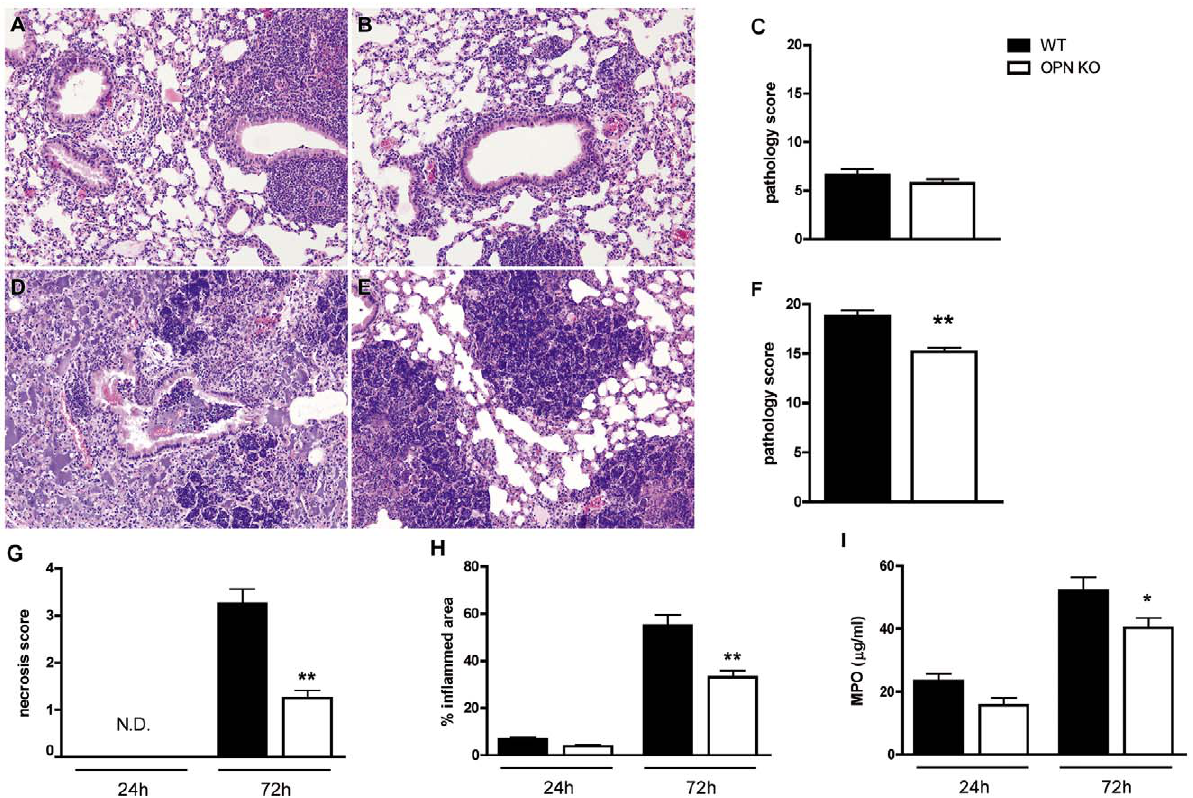
Figure 4. Reduced lung pathology in OPN KO mice. Representative lung pathology of WT (A, D) and OPN KO (B, E) mice 24 (A–C) and 72 (D–F) h after intranasal infection with 10 3 CFU of B. pseudomallei . (G) Necrosis score and (H) the percentage of the inflamed area of the lung. (I) Myeloperoxidase levels in lung homogenates at 24 and 72 h after infection. The lung sections are representative for 8 mice per group per timepoint. H&E staining, original magnification 10 6 . Quantitative data are expressed as means 6 SEM of 8 mice per group. * P , 0.05 and ** P , 0.01 as compared to WT.